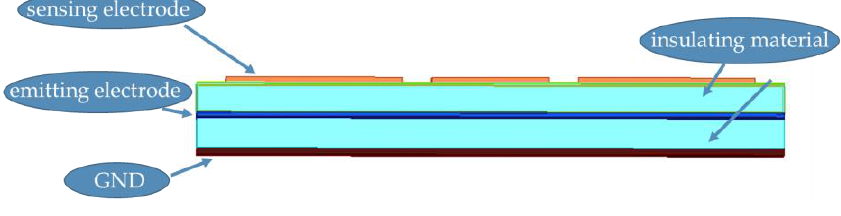
Figure 2. Electric-field detection system structure.